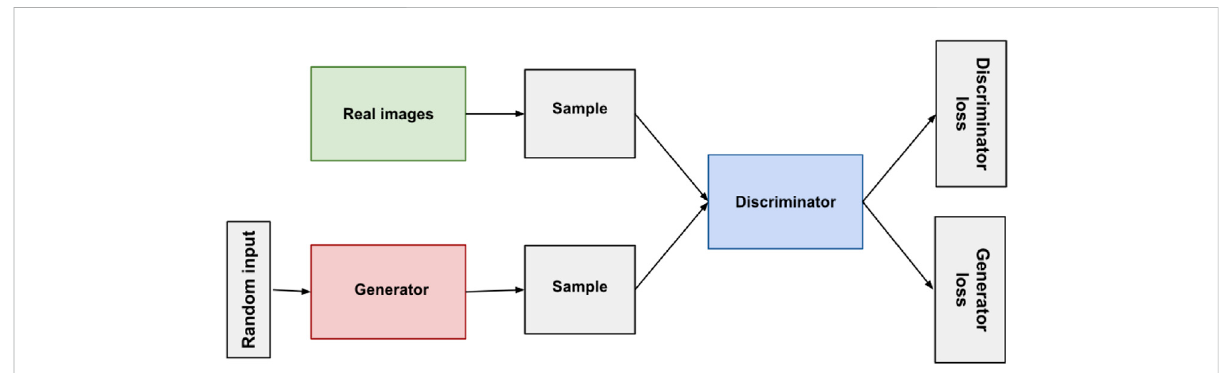
FIGURE 6 Data fl ow in GAN (Google,